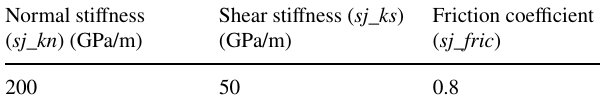
Table 3 Values of microscopic parameters in numerical